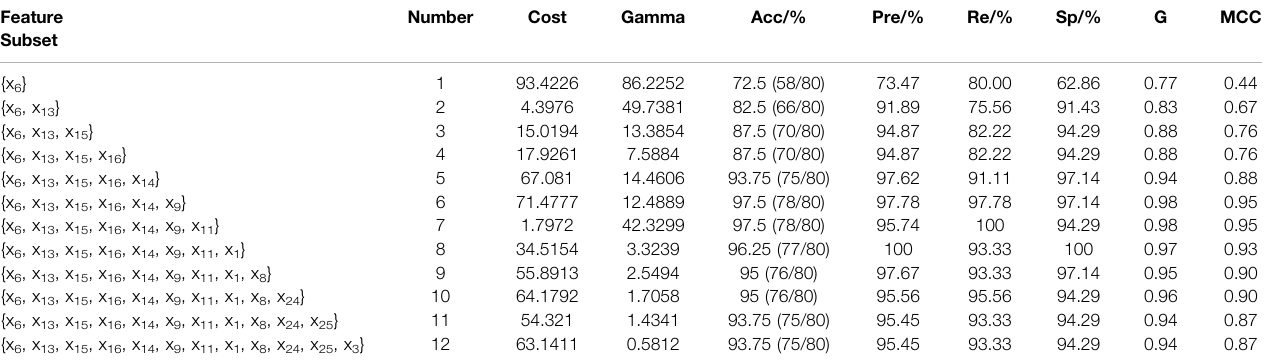
TABLE 3 | The identi fi cation results of the test set of different feature subsets. Feature Subset